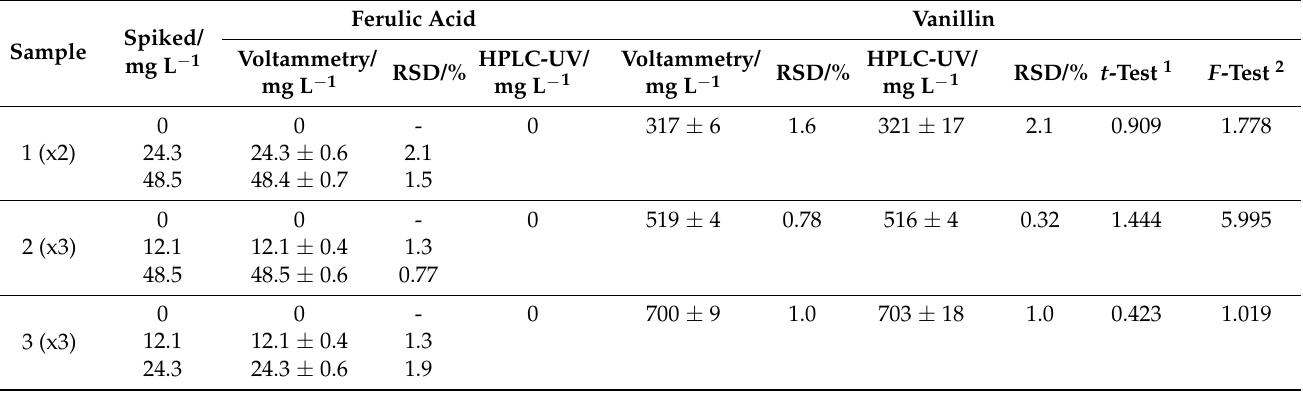
Table 5. Simultaneous quantification of ferulic acid and vanillin in Vanilla planifolia extracts ( p =